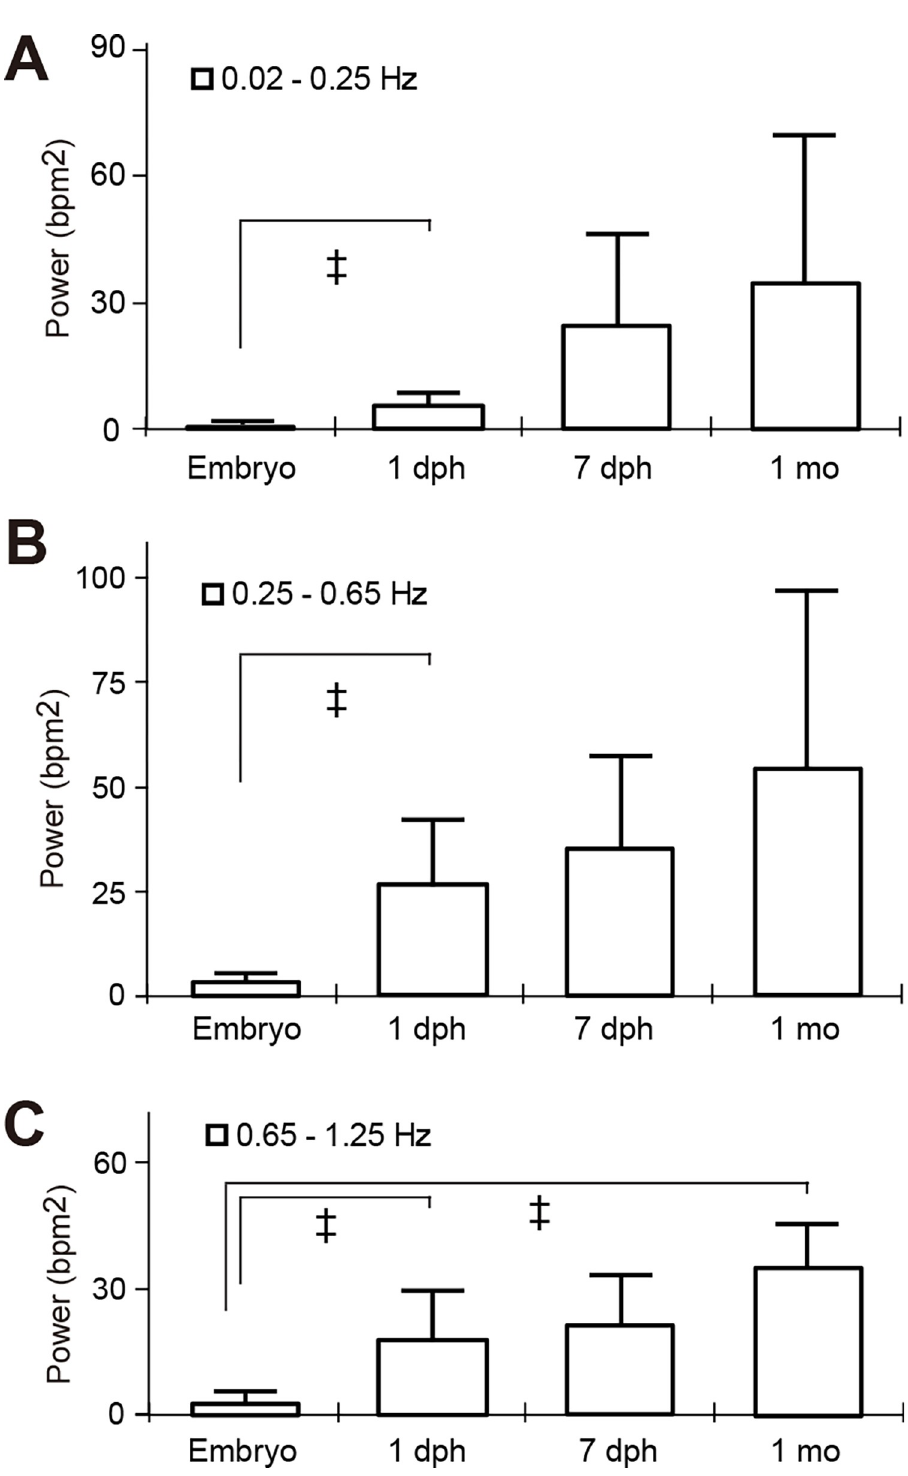
Fig 4. Power spectral analysis of HRV for 3 min during development. Power spectral density and the mean of power spectral density of HRV in st.36 embryos (n = 5), 1 day post hatch (dph) larvae (n = 20), 7 dph larvae (n = 3) and 1 month old juvenile (n = 4) was calculated by fast Fourier transformation using DADiSP software. Low (0.015625–0.25 Hz), middle (0.25–0.65 Hz) and high (0.65–1.25 Hz) frequencies are shown in panels A, B and C, respectively. The amount of power was added in each frequency range and error bars are standard deviations among samples. A, 0.01625–0.25 Hz. B, 0.25–0.65 Hz. C, 0.65–1.25 Hz. ‡ P � 0.005; compared with st.36 embryos.